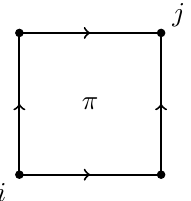
Figure 1 . Two lattice paths that connect sites i and j with a π